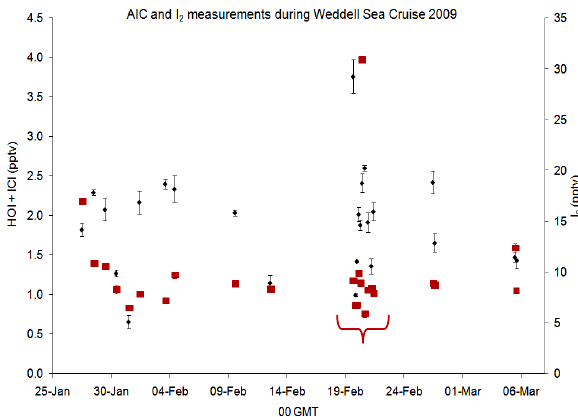
Fig. 3. Atmospheric AIC (HOI + ICl, black diamonds) and I 2 (red squares) concentrations during the field campaign, measurements were made on board the ship, except those denoted by the red downward-pointing bracket that were made on the Brunt Ice Shelf. Each point denotes a 3 hour sample, the mid-sampling time is shown. Average values of triplicate samples are shown, error bars are 1 standard deviation.